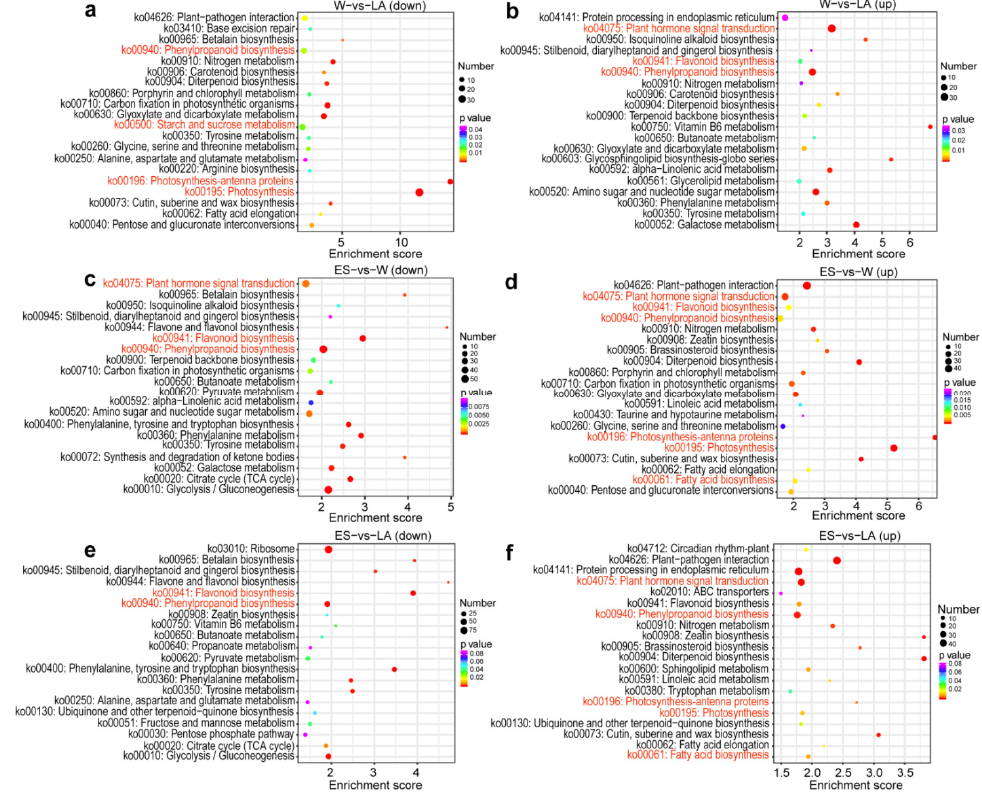
Figure 3. Kyoto Encyclopedia of Genes and Genomes (KEGG) functional annotation of DEGs in overwintering C. fortunei . ( a ) Downregulated DEGs in W vs. LA; ( b ) upregulated DEGs in W vs. LA; ( c ) downregulated DEGs in ES vs. W; ( d ) upregulated DEGs in ES vs. W; ( e ) downregulated DEGs in ES vs. LA; ( f ) upregulated DEGs in ES vs. LA. The x - and y -axes represent the enrichment score and enriched pathways, respectively. The size of the bubble indicates the number of associated DEGs, and the color of the bubble indicates the level of significance. Pathways indicated in red text may be related to overwintering C. fortunei . Sample abbreviations are as follows: ES, early spring; LA, late autumn; and W, winter.